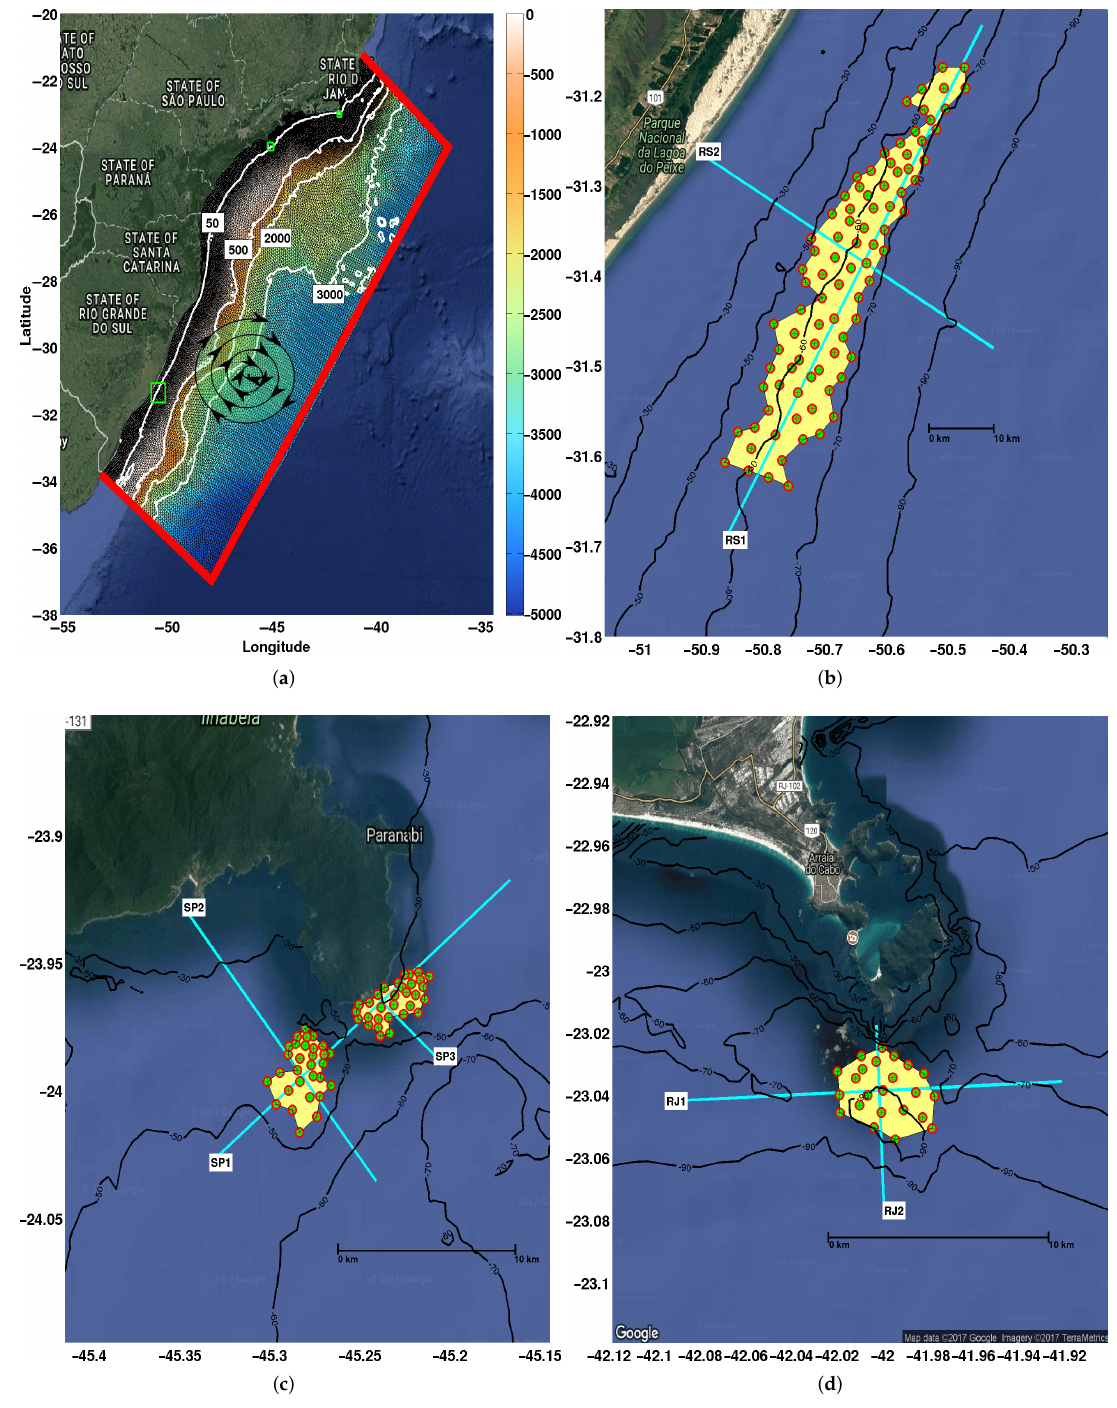
Figure 1. ( a ) Study area located in the South–Southeastern Brazilian Shelf. In addition, the numerical grid used in this work with 205,617 nodes disposed in 20 vertical sigma levels. The red lines represent oceanic liquid boundaries, and the spiral represents atmospheric surface conditions. Bathymetry is shown in the colorbar and also uses isolines for 50, 500, 2000, and 3000 m. The turbines farm are set in three regions marked with green rectangles with 171 turbines, ( b ) where the southern farm (State of Rio Grande do Sul ) possesses 87 turbines and ( c ) the center farm (State of São Paulo) has 61 turbines while ( d ) the northern farm (State of Rio de Janeiro) has 23. At each region, vertical cross sections (cyan lines) were taken for further analysis. (For interpretation of color in this Figure, the reader is referred to the web version of the